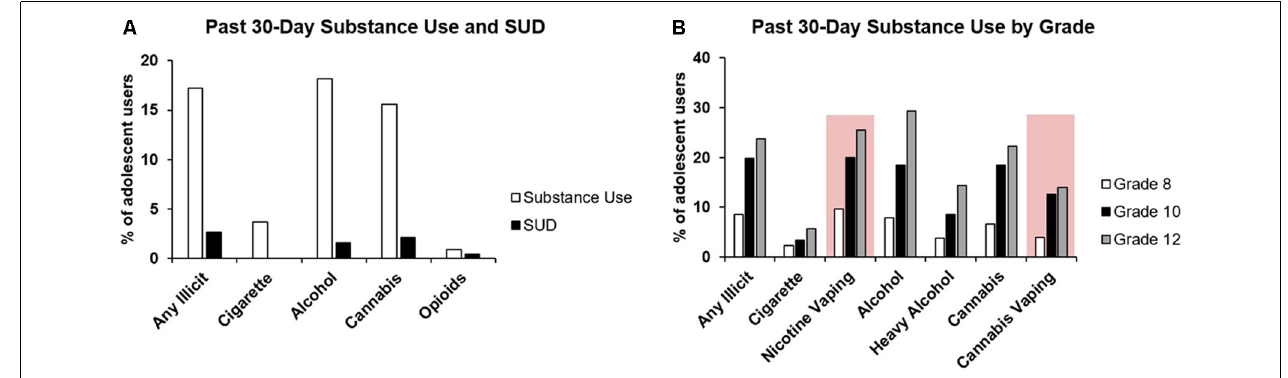
FIGURE 1 | Prevalence of substance use and substance use disorder in adolescents. (A) Collated data from the 2017 National Survey on Drug Use and Health, 2018 National Survey on Drug Use and Health, and 2019 Monitoring the Future Survey showing the past 30-day substance use by U.S. adolescents, along with the reported percentage of adolescents with specific substance use disorders (Substance Abuse and Mental Health Services Administration, 2018, 2019; Johnston et al., 2020). (B) Adolescent substance use by school grade (8, 10, 12) as per the 2019 Monitoring the Future report (Johnston et al., 2020). All categories represent self-reported substance use in the past 30 days except for heavy alcohol use (five or more drinks in a row) in the past two weeks. Emerging substance use behaviors (i.e., nicotine and cannabis vaping) are highlighted by a red